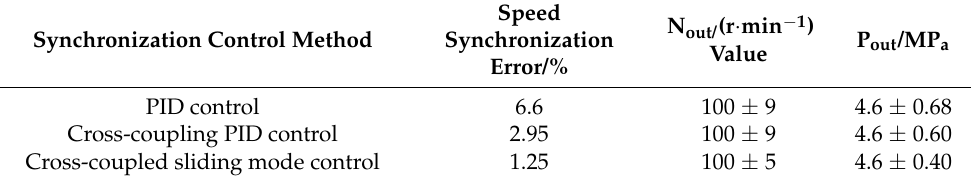
Figure 8. Pressure Output Curve of Double-channel Motor. Table 2. Comparison of Synchronization